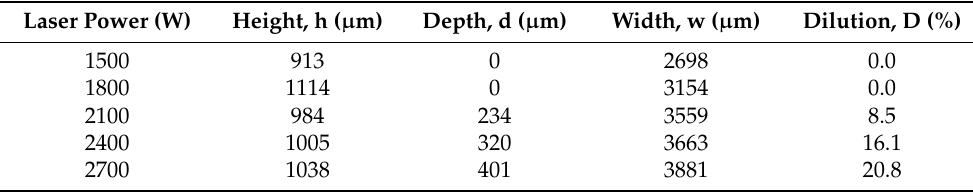
Table 3. Geometrical parameters of laser cladded Ni-20Cr+Re beads measured on the cross-section of the samples.